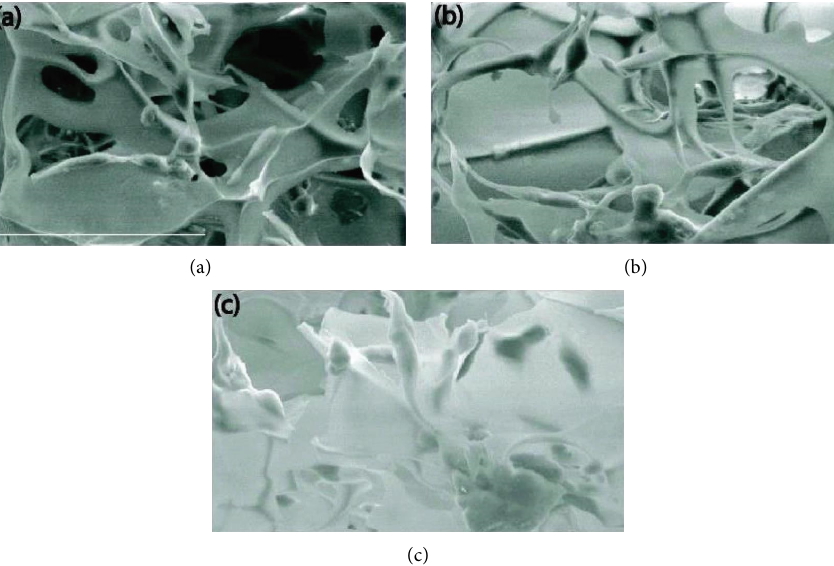
Figure 3: Te morphology of the cells on (a) CHI-100, (b) CHI-90, and (c) CHI-80 scafolds. Te scale bar in the images represents 60 μ